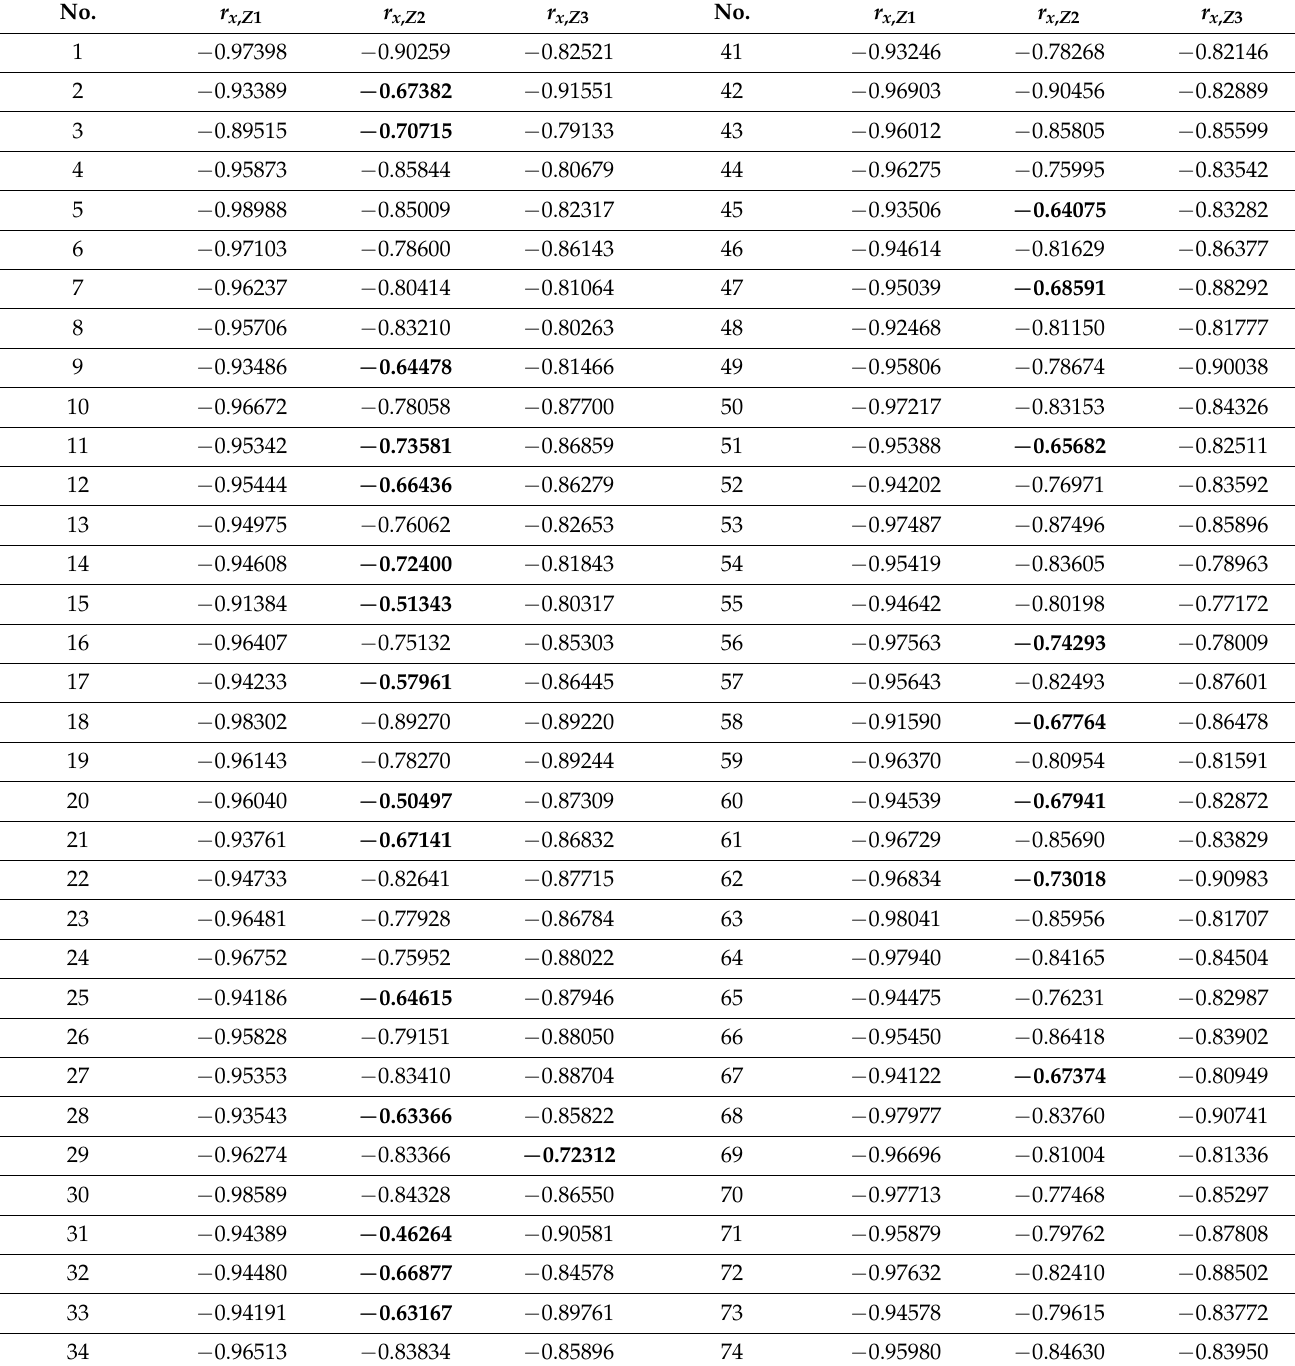
Table 7. Obtained correlation values between the objective value and matrices for different